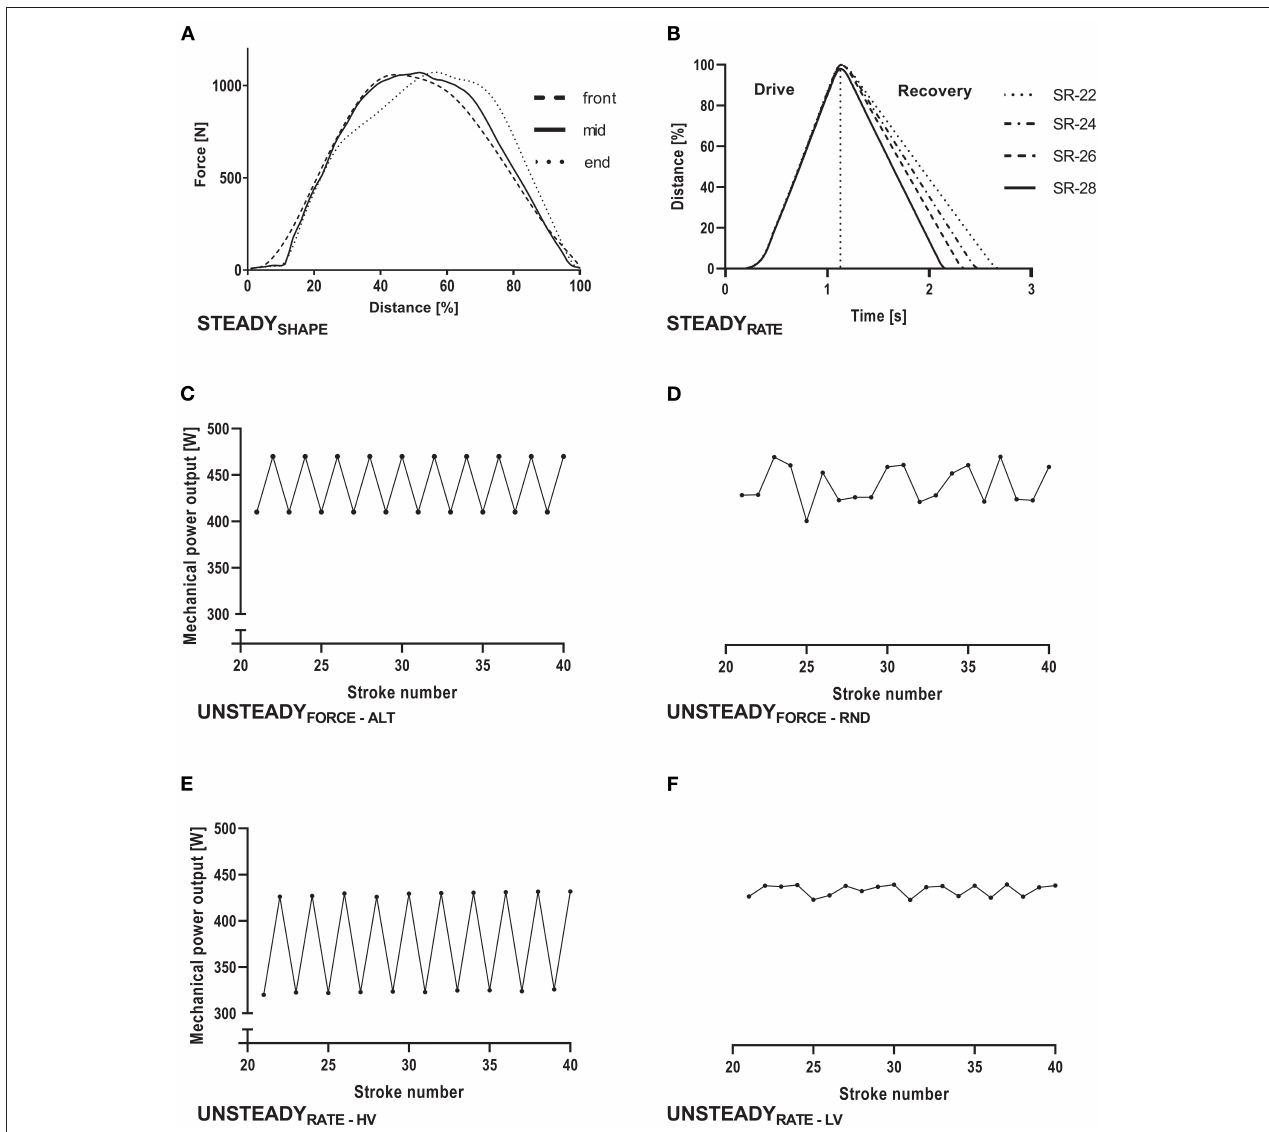
FIGURE 1 | Schematic overview of the experimental design to evaluate differences in mechanical power output between the reference system of a test rig for air-braked rowing ergometers and the Concept 2 Indoor Rower’s PM5 Monitor. In (A,B) the influence of stroke shape and stroke rate was tested during steady simulated rowing, i.e., stroke-to-stroke variability was as low as possible during each measurement series. (A) Shows three different stroke shapes (front-, mid- and end-emphasized) that were applied, while (B) visualizes four different stroke rates (SR) of 22, 24, 26 and 28 min − 1 . (C–F) depict the mechanical power output (detailed excerpt of strokes 20–40) during unsteady experiments, where stroke-to-stroke variability was experimentally augmented by regular [ALT, (C) ] or random manipulations of stroke force [RND, (D) ]. Finally, stroke rate was manipulated highly and regularly [HV, (E) ] or slightly and randomly [LV, (F) ], while force was kept